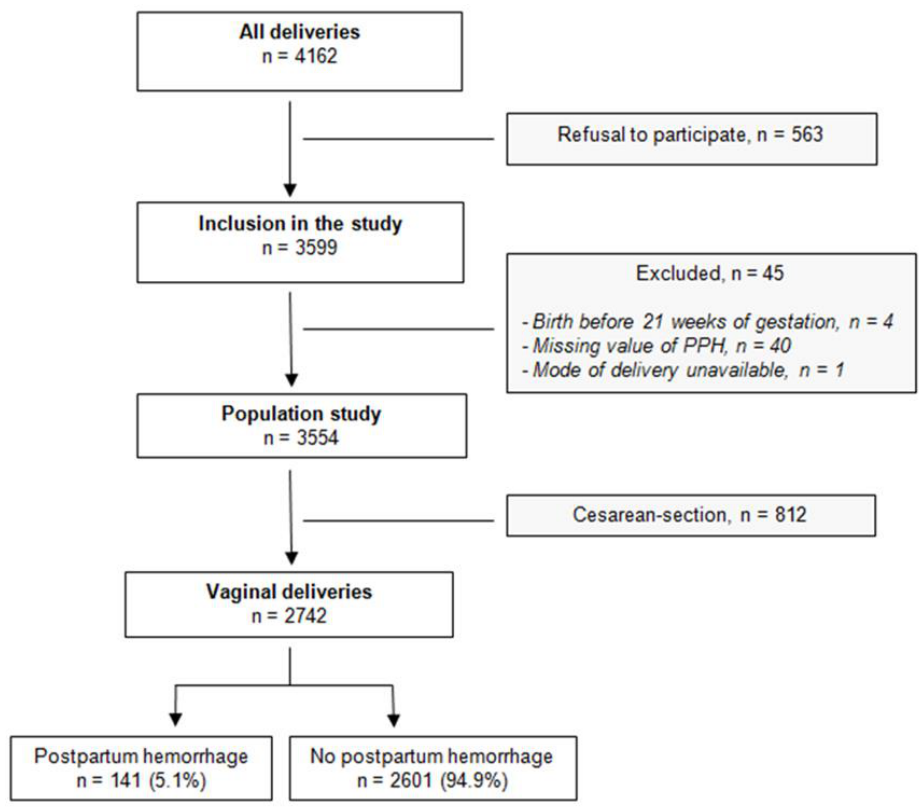
Figure 1. Flowchart of the derivation monocenter cohort.